Question: Condense the content of this figure into a single sentence.
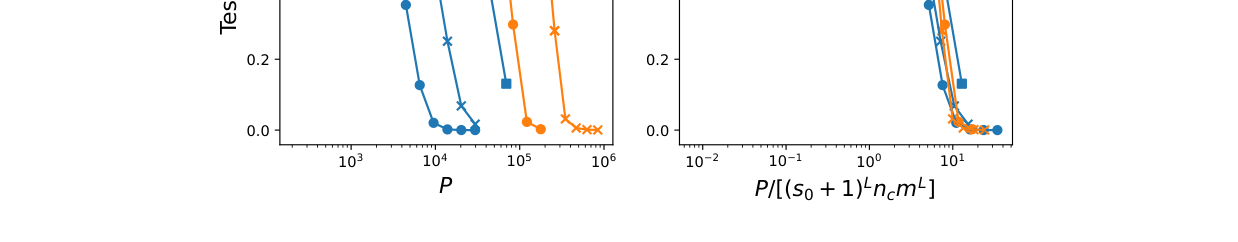
Answer: Left: test error versus number of training points P of LCN trained on the SRHM with sparsity B (described in Figure 2, panel (3)), with different L (different colors), different s0 (different markers), s = 2 and m = v = nc = 6. Right: same as left but rescaling P by Eq. 3.